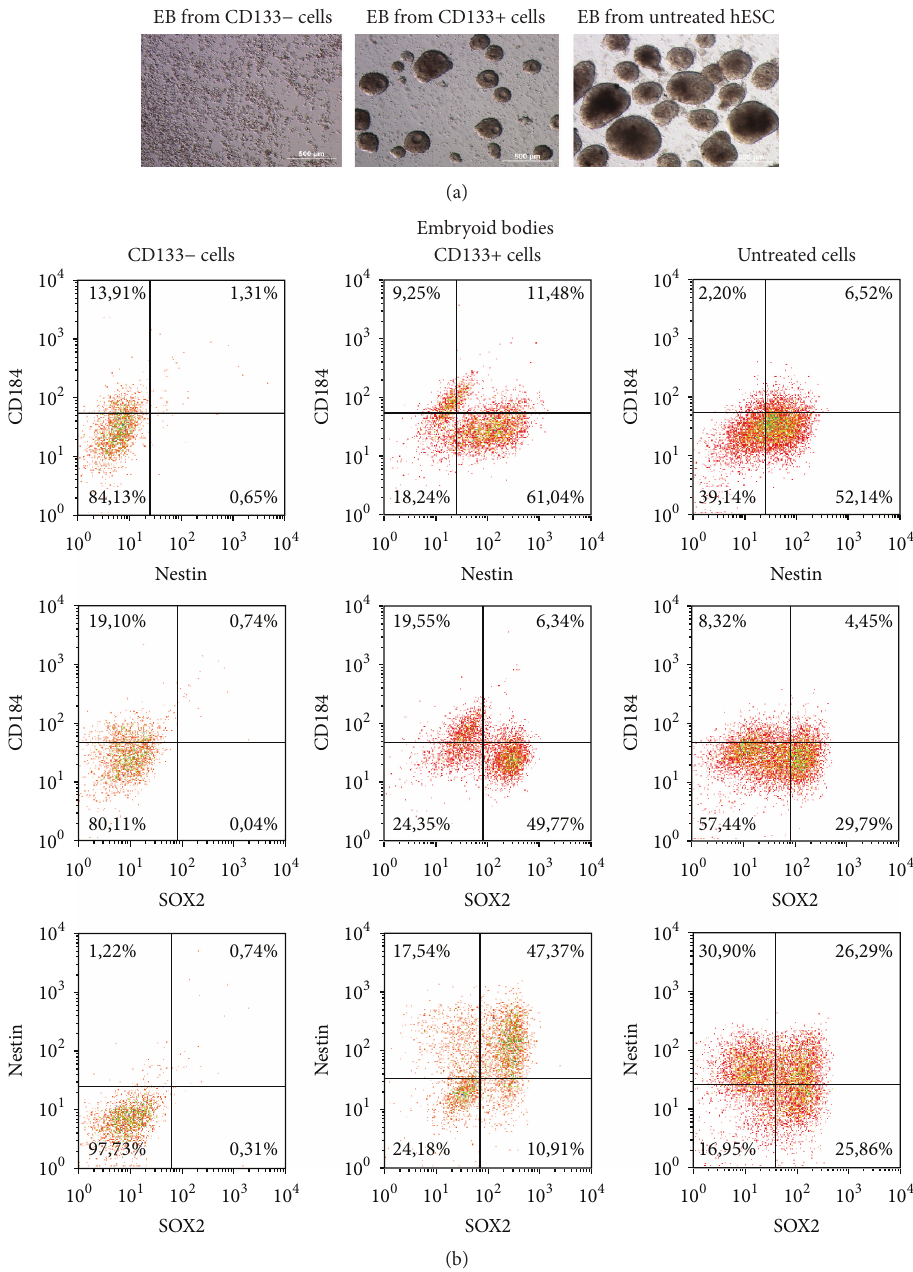
Figure 7: CD133 expression was crucial for proper differentiation into embryoid bodies. CD133+ and CD133 − cell subpopulations were enriched using the magnetic beads separation method from untreated hES cells and the formation of EB was initiated. (a) Morphology of the formed structures on day five. (b) Formed EB and cell structures were analysed for the expression of CD184, nestin, and SOX2.